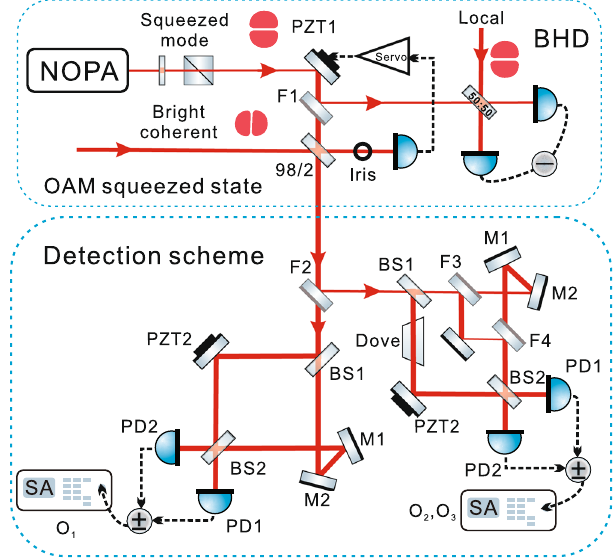
Figure 4. Experimental set-up for the generation and detection of OAM squeezed states. PZTs: piezoelectric transducers, 98/2: 98/2 beam splitter, BSs: 50/50 beam splitter, Ms: high-reflectivity mirrors, Fs: flip mirrors, Dove: Dove prism, PDs: photodetectors,( + / − ): positive/negative combiner, SA: spectrum analyser, Servo: servo amplifier circuit for feedback